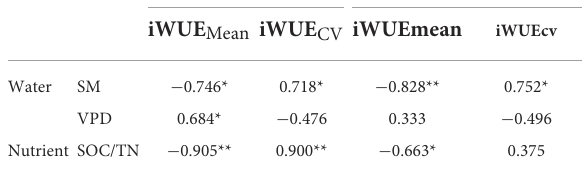
TABLE 1 Pearson’s correlation coefficients between intrinsic water use efficiency and environmental variables in Loess Plateau (LP) and Inner Mongola Plateau (MP).